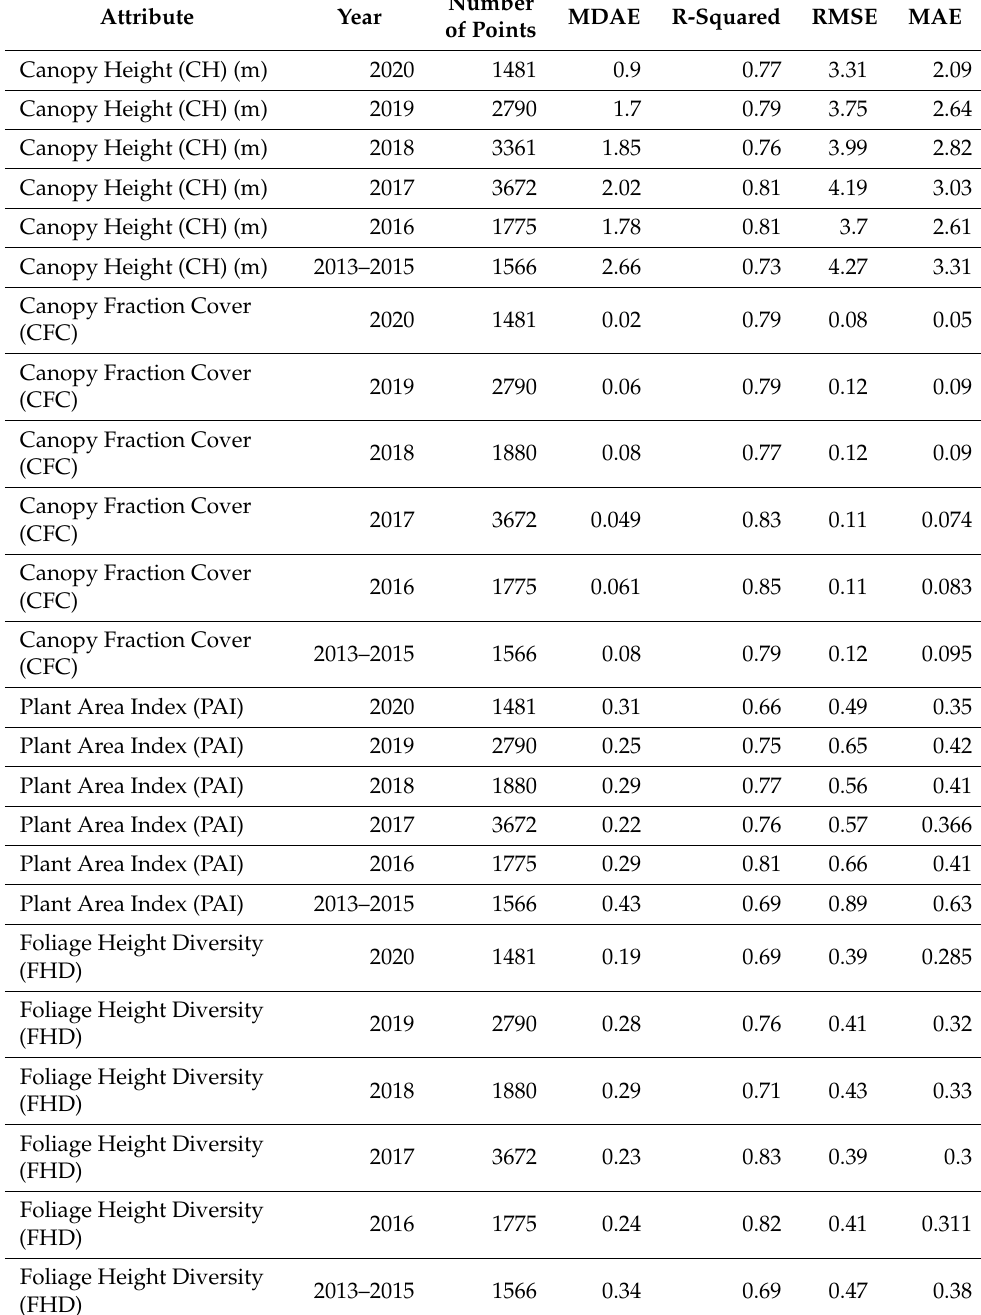
Table 12. Evaluation results of the annual mapped products’ comparison with the ALS data for the period